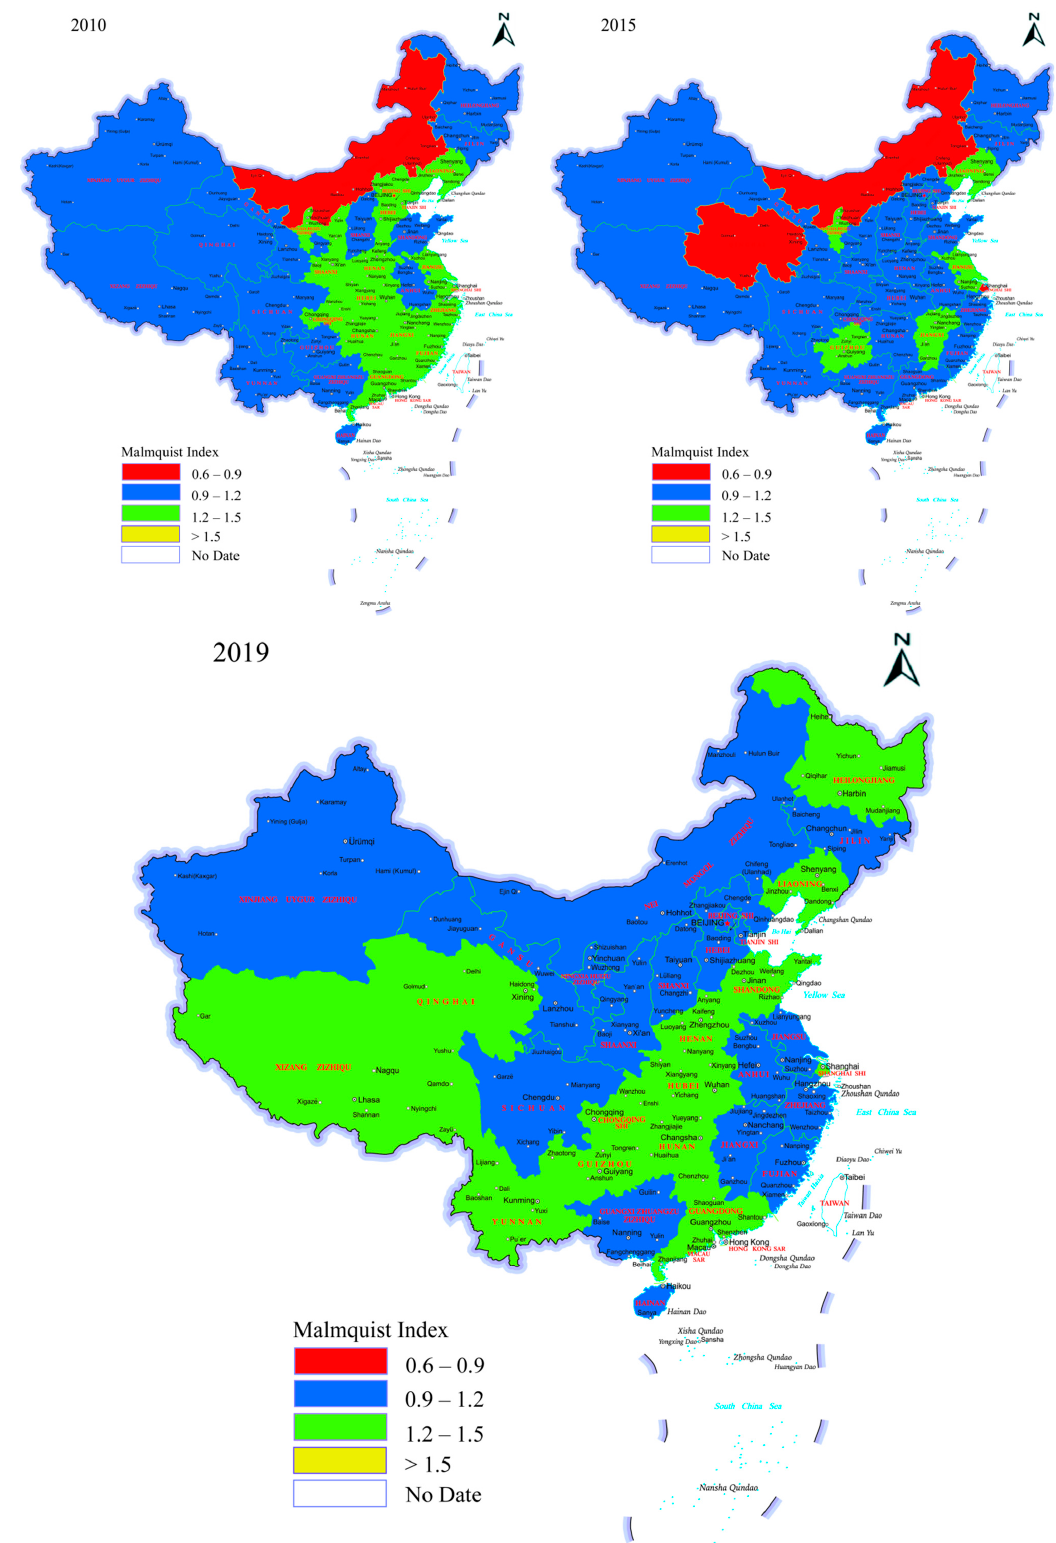
Figure 1. AGTFP in 2010, 2015 and 2019. By comparing the growth of the eastern, western and central regions (Figure 2), it was obvious that the western region and the central region had achieved continuous growth in AGTFP, with an average annual growth rate of 0.4% and 1.2%, respectively. The growth of the main sales area was driven by the contribution of green technology progress (GTC), which increased by 1.5% and 1.8%, respectively. Specifically, the effi- ciency of pure green technology (PGT) in the western region had not declined, although there was no improvement in green technology efficiency (GTE). However, the situation in the eastern region was not satisfactory, with an average annual decline of 4.7%, a large decline. In addition, GTC and GTE were declining (Figure 3), reflecting that the pollution and carbon emissions in the eastern region were becoming more serious, and special at- tention was required to take targeted environmental protection measures. The volatility of AGTFP in the eastern, central and western regions was clear, and the eastern region was the most fluctuate. In particular, the AGTFP in the eastern region showed a rapid growth in the 2015–2019 period.